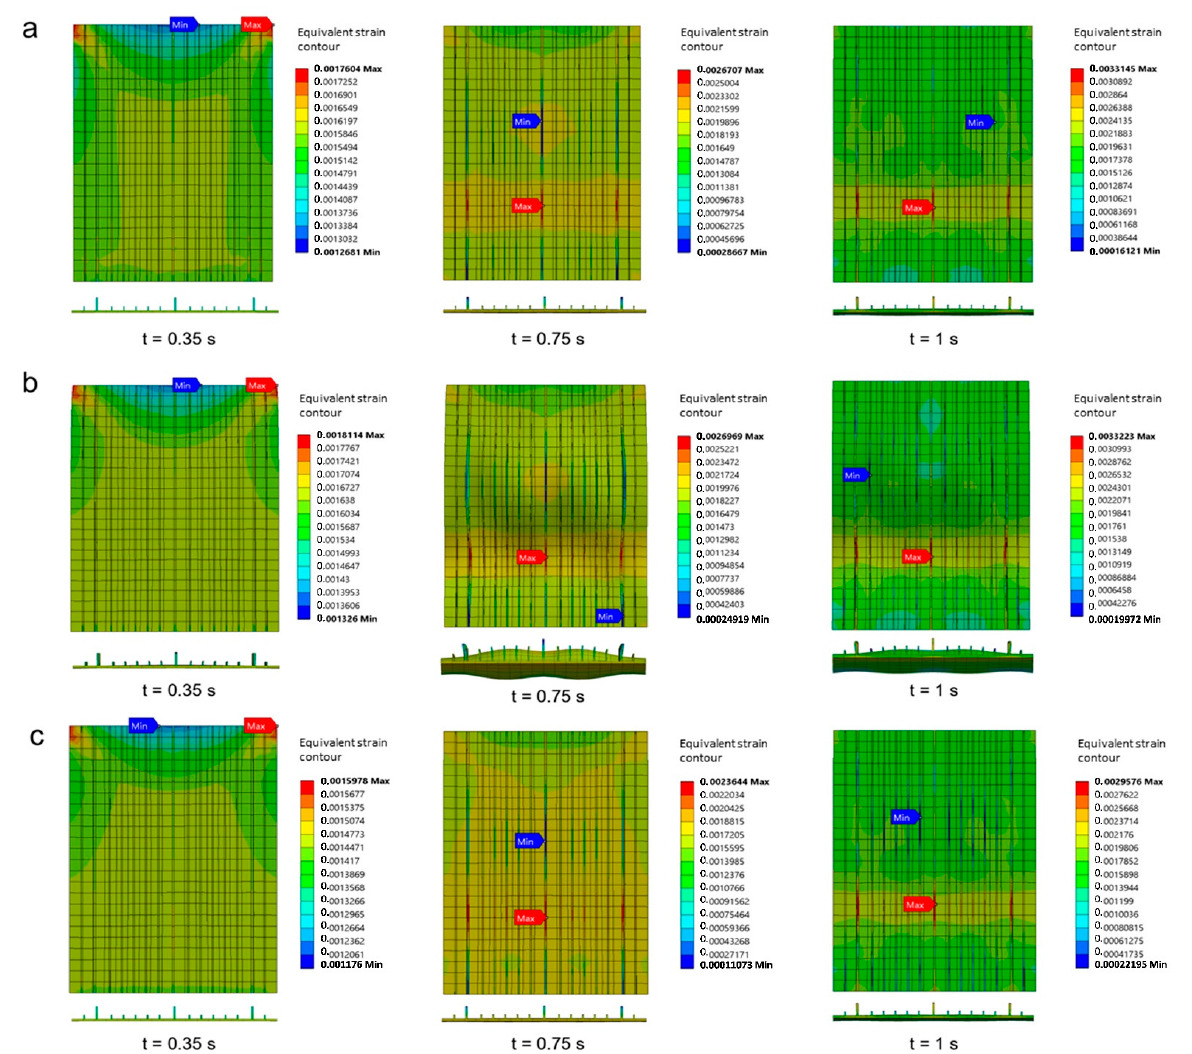
Figure 25. Equivalent strain contour in Specimen B. ( a ) 2 mm sub-stiffeners thickness; ( b ) 2.5 mm sub-stiffeners thickness; ( c ) 3 mm sub-stiffeners thickness.